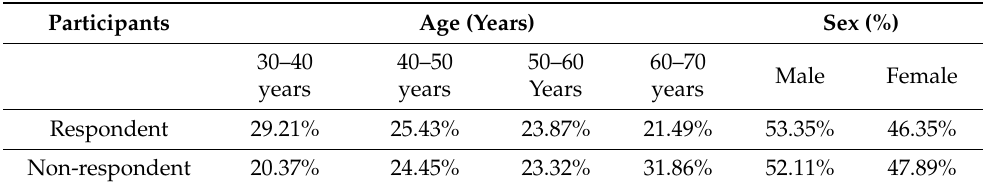
Table 1. Participants’ general